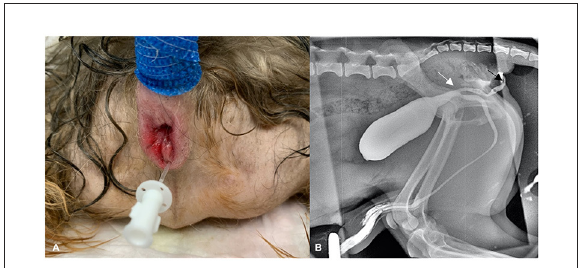
FIGURE1 (A) Perineal region in a 2-year-old male dog with a urethral duplication. Note the catheterized opening of the ectopic urethra in annus. (B) A retrograde cystogram was preformed to identify the location of duplication of the urethra and its length. Note its beginning (white arrow) and ending (black arrow).